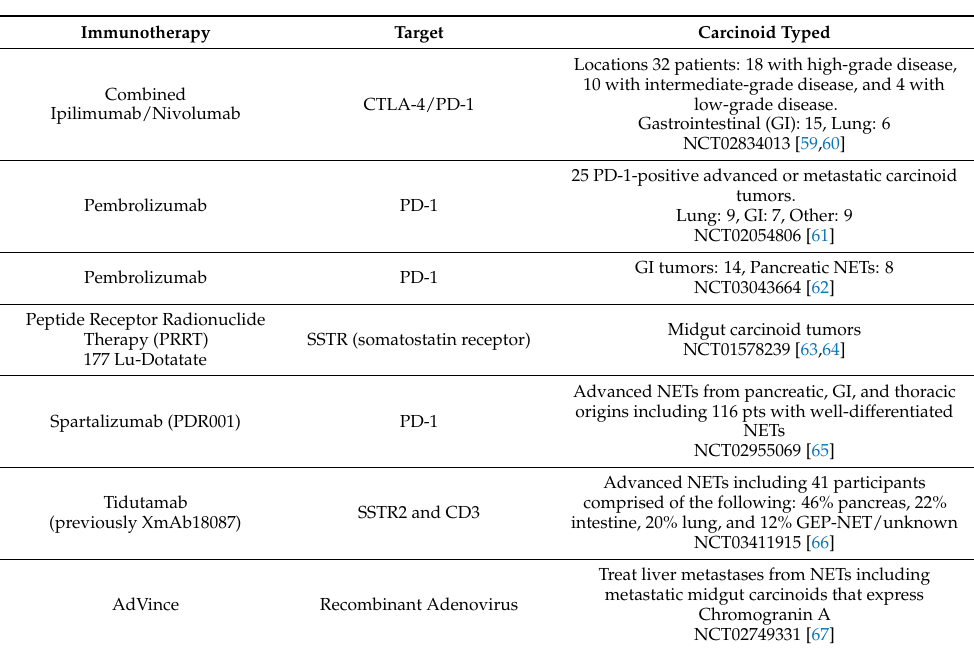
Table 3. Immunotherapeutics for Carcinoid